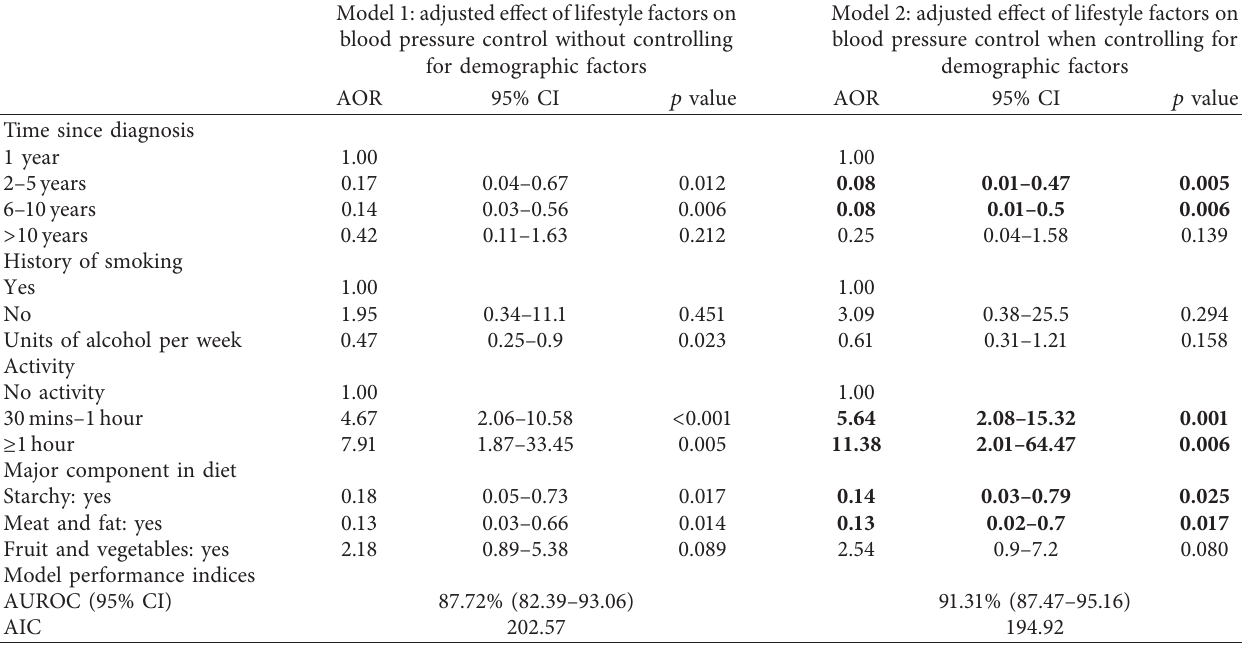
Table 3: Models used in assessing the effect of lifestyle factors on blood pressure control among urban adults. Model 1: adjusted effect of lifestyle factors on